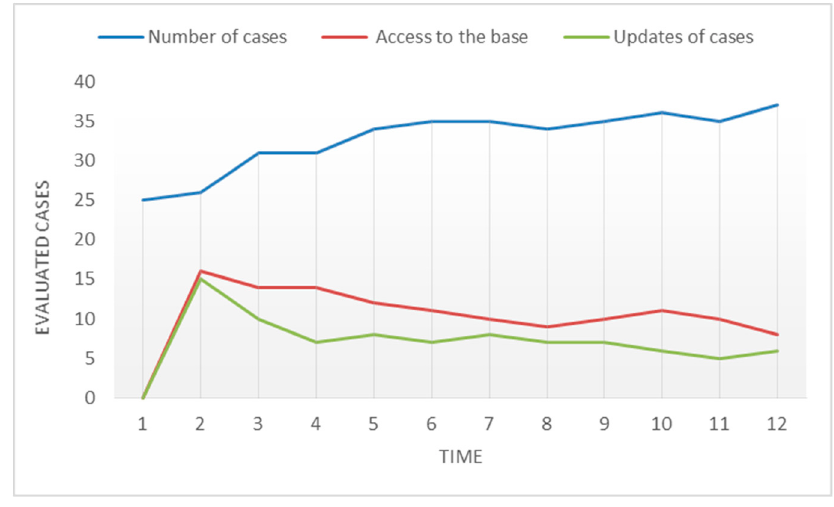
Figure 15. Evolution of the